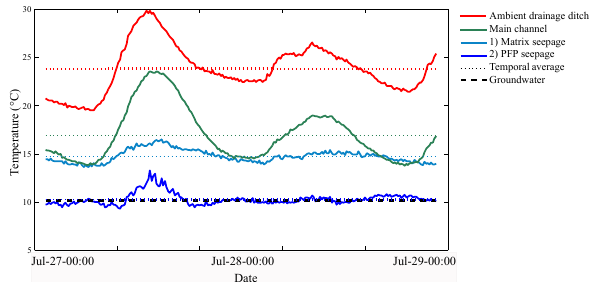
Figure 3. Fiber-optic distributed temperature sensing (FO-DTS) temperature time series from four 1m segments of cable to illustrate the characteristic thermal signatures at Tidmarsh Farms. The great- est amplitude and variability occurs in the drainage ditches with little flow and significant solar heating (red), followed by the main channel of Beaver Dam Brook (green). Two seepage types are also plotted over 2.5 days: matrix (type 1) seepage, with very low vari- ability (low standard deviation) over time and a mean temperature a few degrees higher than groundwater (light blue) and preferential flow-path (type 2) seepage with a mean temperature nearly equal to groundwater (dark